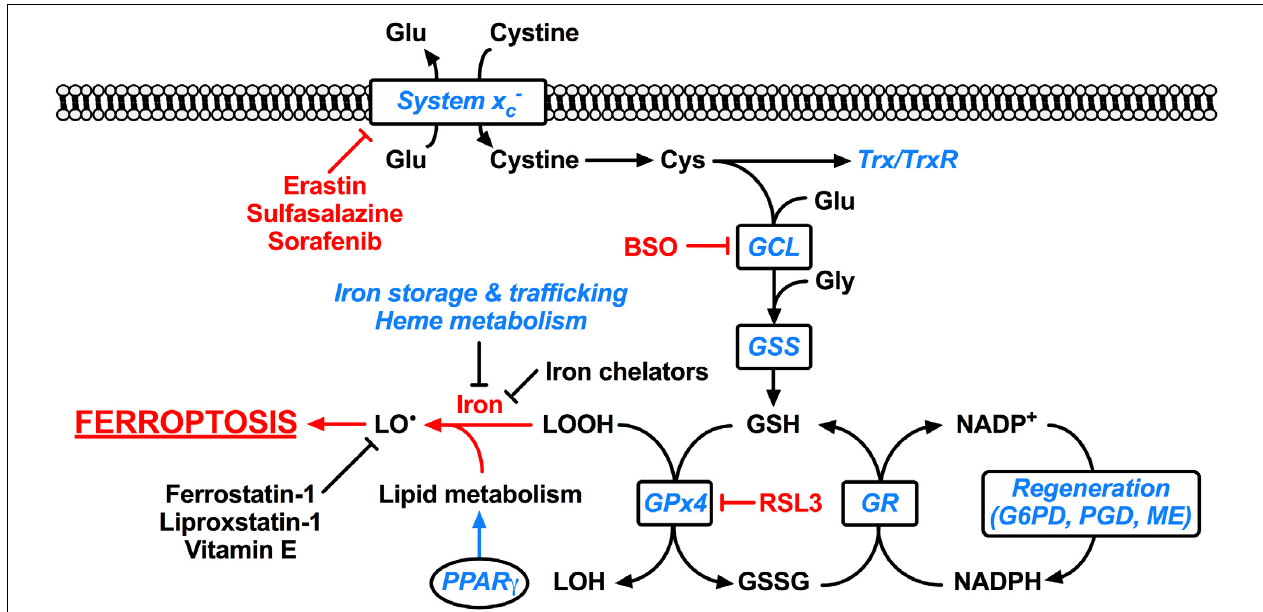
FIGURE 1 | Ferroptosis and its molecular regulation by Nrf2. Glutathione peroxidase 4 (Gpx4) utilizes the major cellular antioxidant glutathione (GSH) as a substrate to reduce lipid hydroperoxides (LOOH). Oxidized glutathione (GSSG) generated by Gpx4 is reduced back to glutathione by glutathione reductase (GR) in a reaction requiring NADPH, which can be regenerated by glucose-6-phosphate dehydrogenase (G6PD) and phosphogluconate dehydrogenase (PGD) of the pentose-phosphate pathway, and malic enzyme (ME). The tripeptide glutathione is synthesized by the consecutive action of glutamate-cysteine ligase (GCL) and glutathione synthetase (GSS), where the ligation of cysteine (Cys) and glutamate (Glu) by glutamate-cysteine ligase is the rate-limiting step of glutathione synthesis. The cellular import of cystine by the glutamate-cystine antiporter system x c − constitutes an significant route of cysteine supply for glutathione synthesis. Cysteine is also required for other important cellular antioxidants including thioredoxin (Trx) and thioredoxin reductase (TrxR). Ferroptosis occurs when the Gpx4-catalyzed reduction of lipid hydroperoxides is insufficient to prevent the iron-mediated generation of lipid radicals (LO • ). This leads to the propagation of lipid peroxidation and culminates in ferroptosis. Ferroptosis can be experimentally induced by inhibiting Gpx4 via the small molecule inhibitor RSL3, or by limiting glutathione supply to Gpx4. The latter is induced by direct [e.g., buthionine sulfoximine (BSO)] or indirect (e.g., by limiting cysteine availability) inhibition of glutathione synthesis. Cysteine supply is disrupted by inhibitors of system x c − including erastin, sulfasalazine, and sorafenib. Ferroptosis can also be inhibited by iron chelators such as deferoxamine and deferiprone, and lipid radical scavengers such as ferrostatin-1, liproxstatin-1, and vitamin E. Factors transcriptionally regulated by Nrf2 are indicated in blue italics, whereas factors promoting ferroptosis are indicated in red. Clearly Nrf2 signaling is likely to have an integral and pervasive impact on the manifestation of